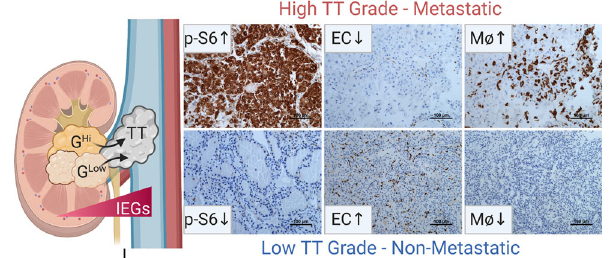
Fig. 7 Determinants of invasion and metastatic competence in invasive intravascular RCC. Model highlighting key fi ndings from the study. IEG overexpression in TT was based on gene expression analysis of biologically independent PT ( n = 114) and TT ( n = 161) samples. Tumor grade was analyzed using matched PT and TT from 71 ccRCC patients. Representative IHC images shown for p-S6 ( n = 65 patients, 81 samples), Endothelial Cells (EC, anti-ERG, n = 20 patients, 36 samples), and Macrophages (M ϕ , anti- CD163 n = 20 patients, 36